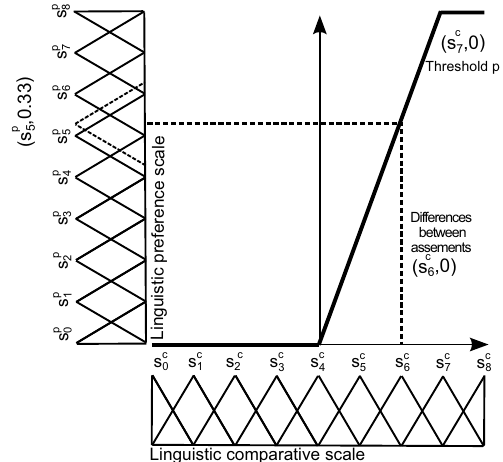
Fig. 3. Linguistic preference value that is computed by Type III linguistic preference